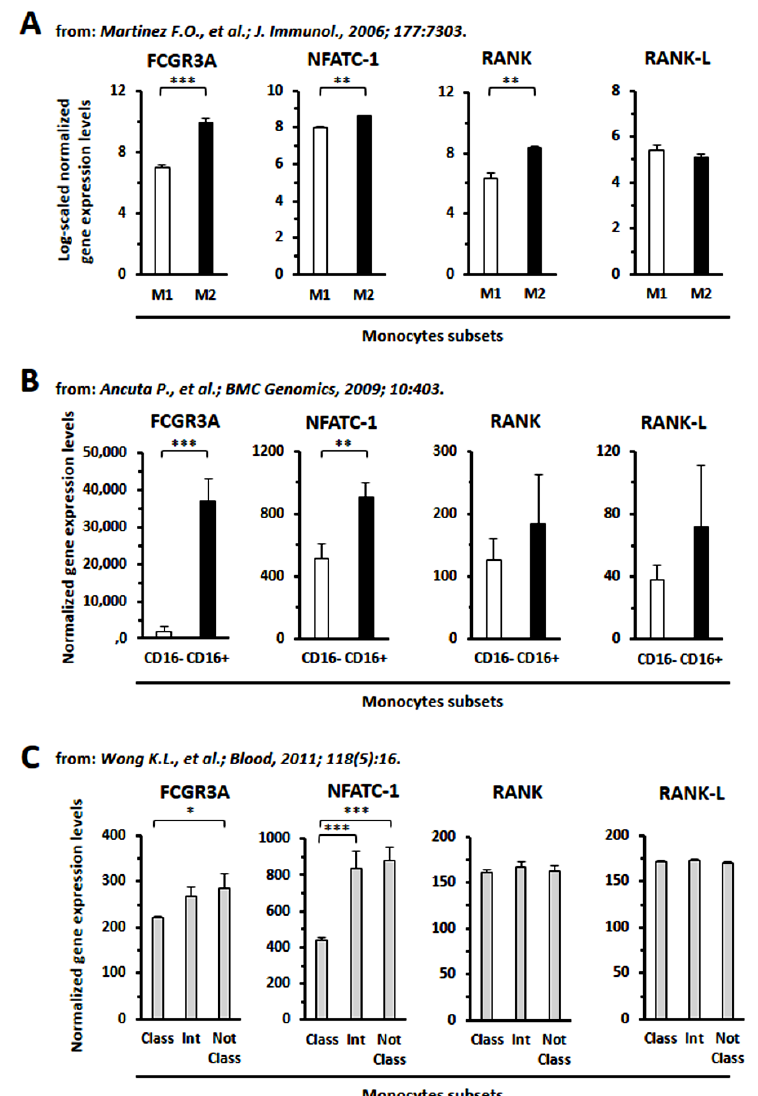
Figure 11. Analysis of gene expression profiles of transcripts for molecules specifically involved in osteoclasto-genesis, as derived from available public literature data. ( A ) Monocytes of type M2 expressed significantly higher transcript levels of CD16 (FCG3A), NFATC1 and RANK in comparison with M1. ( B ) The expression of NFATC1, the key osteoclastogenic transcription factor, also appeared significantly higher in CD16-positive monocytes versus CD16-negative. ( C ) The “intermediate” and “non - classical” monocytes showed significantly higher levels of NFATC1 in comparison with the “classical subtype”. Statistical significance was achieved with Student t test for panels ( A ) and ( B ) and with ANOVA and Tukey’s post hoc test.